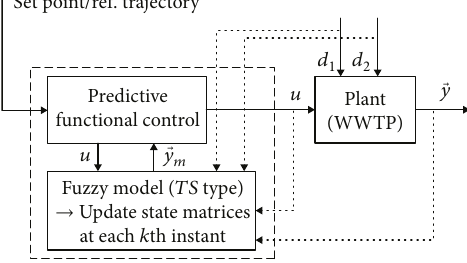
Figure 12: FMBPC scheme with an internal fuzzy